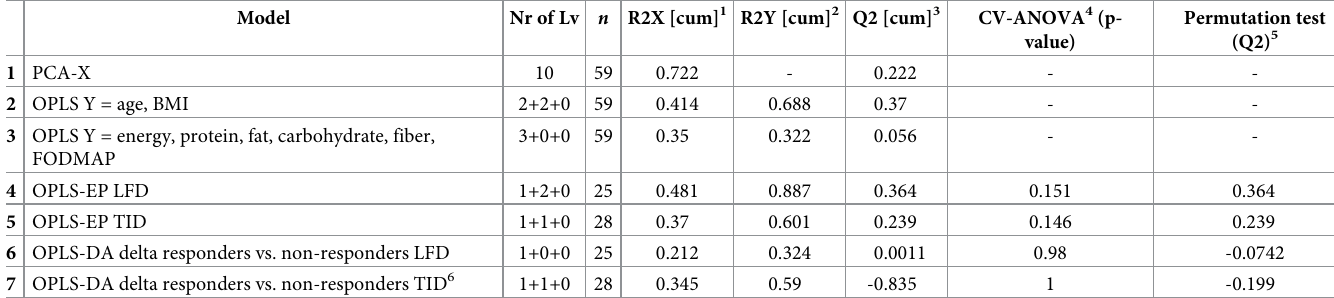
Table 2. Multivariate models in serum from participants receiving a low FODMAP diet and traditional IBS diet.